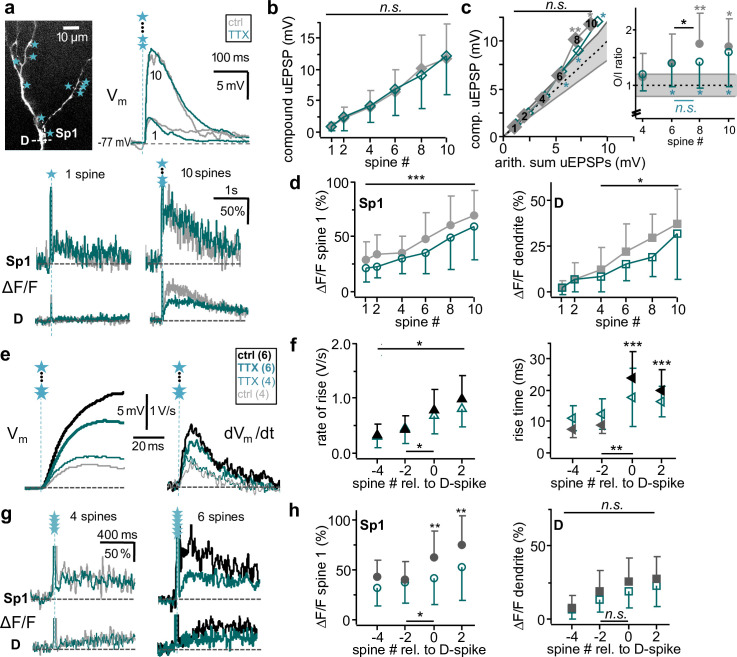
Molecular mechanisms of subthreshold integration: Navs.a: Example Nav blockade experiment. Top left: Stimulated spine set with line scan sites Sp1, D, and uncaging spots. Top right: Somatic Vm recording of compound uEPSPs, below spine Sp1 and dendrite D ΔF/F for 1 and 10 spines. Gray traces: control. Blue traces: TTX (0.5–1 μM). b: Effect (n = 12 cells) of 0.5–1 μM TTX on somatic compound uEPSP amplitude upon activation of 1, 2, 4, 6, 8, and 10 spines. Repeated measures 2-way ANOVA (Materials and methods, also in d,f, h): no interaction effect (spine # x TTX): F(5,119) = 2.54, p = 0.091; no TTX effect: F(1,119) = 0.97, p = 0.352. c: Cumulative effect (n = 12 cells) of Nav blockade on averaged sO/I. No interaction effect (spine # x TTX): F(5,99) = 1.60, p = 0.195; no TTX effect: F(1,99) = 0.84, p = 0.385 (n.s. above). Lines and grey asterisks as in Fig 1C. The average O/I ratio for 8 spines was highly significantly supralinear in control (** above data points, p < 0.01) and significantly increased versus 6 spines (* in inset, p < 0.05, Wilcoxon test). In TTX, O/I ratios were still significantly supralinear (* below data points, p < 0.05 for all), but the increase from 6 to 8 spines disappeared (inset, n.s. below). d: Effect of Nav blockade on average ΔF/F in spine 1 (Sp1, left, n = 25 spines in 11 cells) and dendrites (D, right, n = 12) upon activation of 1–10 spines. No interaction effect on spine 1 ΔF/F (spine # x TTX): F(5,239) = 1.69, p = 0.145; TTX effect: F(1,239) = 15.16, average reduction to 0.89 ± 0.54 of control, p < 0.001. No interaction effect on dendrite ΔF/F from 4 spines onwards (spine # x TTX): F(3,79) = 0.46, p = 0.715; TTX effect: F(1,79) = 9.29, average reduction to 0.75 ± 0.28 of control, p = 0.014. Asterisks above error bars: significance of difference TTX versus control. e: Example for effect of TTX on compound uEPSP kinetics below and at D-spike threshold (4 and 6 coactivated spines in this granule cell, respectively). Left traces: Vm, right traces: dVm/dt. Gray/black traces: control. Blue traces: TTX (0.5–1 μM). Thin lines: 4 spines, thick lines: 6 spines. Note the reduction in maximal rate of rise above threshold but not subthreshold. f: Cumulative data for effect of TTX (n = 7 cells with supralinear sO/Is) on compound uEPSP rate of rise (left) and rise time (right). Repeated measures two-way ANOVA (see Materials and methods, also below): no interaction effect on rate of rise (spine # x TTX): F(3,55) = 3.06, p = 0.055; TTX effect: F(1,55) = 8.25, p = 0.028. Interaction effect on rise time (spine # x TTX): F(3,55) = 12.49, p < 0.001. Asterisks indicate significance of differences between TTX and control (*p = 0.028, *** p < 0.001). Asterisks at bottom indicate significance of differences of parameter increases from -2 to 0 between control and TTX (Wilcoxon test; rate of rise: p < 0.05 [W = 17, nsr = 6], rise time: p < 0.01 [W = 28, nsr = 7]). See S2C Fig for individual data points. g: Example for effect of TTX on spine 1 and dendrite ΔF/F below and above D-spike threshold (4 and 6 coactivated spines, respectively; same cell as in e, same color code). Note the reduction in spine 1 ΔF/F by TTX at threshold but not subthreshold. h: Cumulative data for effect of TTX (n = 7 cells with D-spike) on ΔF/F in spines (left, n = 13) and dendrite (right, n = 7). Full symbols: control, open symbols: TTX. Repeated measures 2-way ANOVA (see Materials and methods): interaction effect on spine ΔF/F (spine # x TTX): F(3,103) = 3.20, p = 0.035. No interaction effect on dendrite ΔF/F: F(3,55) = 0.66, p = 0.588; no TTX effect: F(1,55) = 5.10, p = 0.065. Asterisks above indicate significance of differences between TTX and control. Asterisks at bottom indicate significance of differences of ΔF/F from −2 to 0 between control and TTX (Wilcoxon test; spine S: p = 0.029 [W = 55, nsr = 13], dendrite: not significant [W = −2, nsr = 5]). See S2C Fig for individual data points. arith., arithmetic; D-spike, dendritic Na+-spike; n.s., not significant; sO/I, subthreshold output/input; TTX, tetrodotoxin; uEPSP, uncaging-evoked excitatory postsynaptic potential.